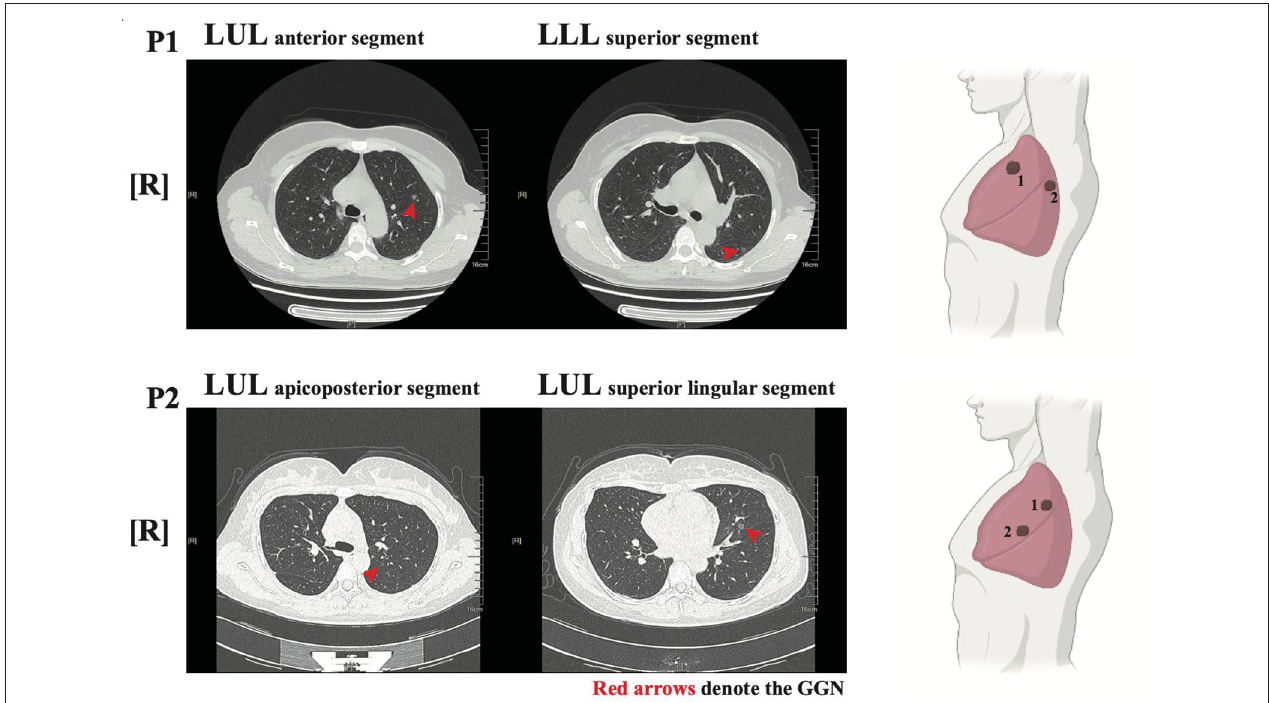
FIGURE 1 | Radiological features of the two patients. left panel: Chest low-dose CT (LDCT) scans with two ground-glass nodules (GGNs, red arrows) of P1/P2; Right panel: illustration showed the location of GGNs in lung lobes.